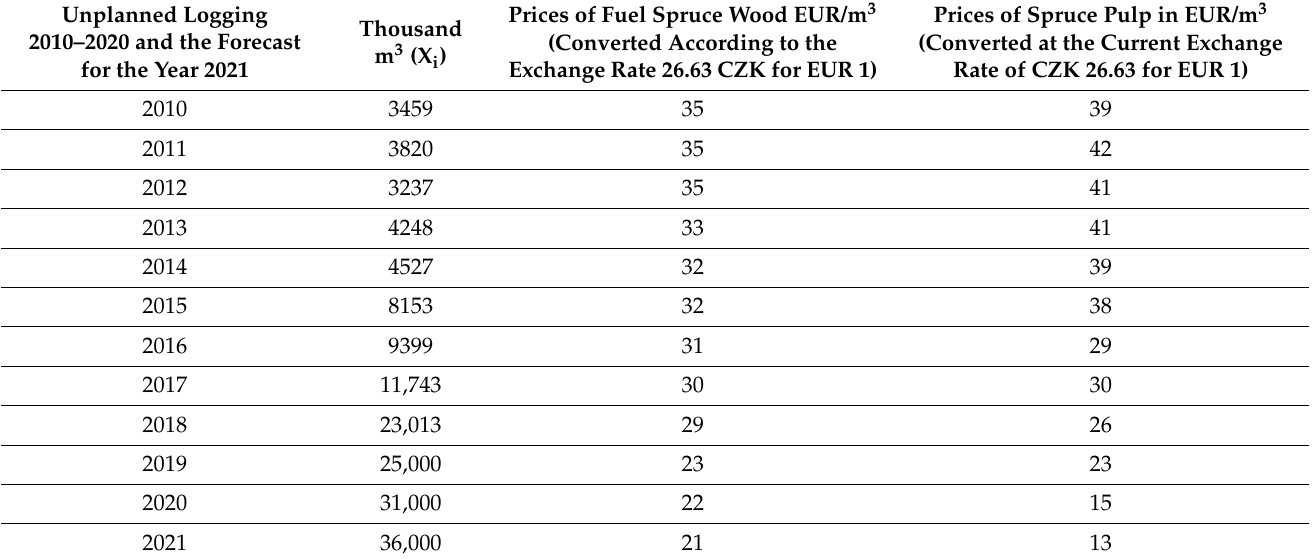
Table 1. Volume of the unplanned salvage logging and price of spruce wood (in EUR/m 3 ) between 2010 and